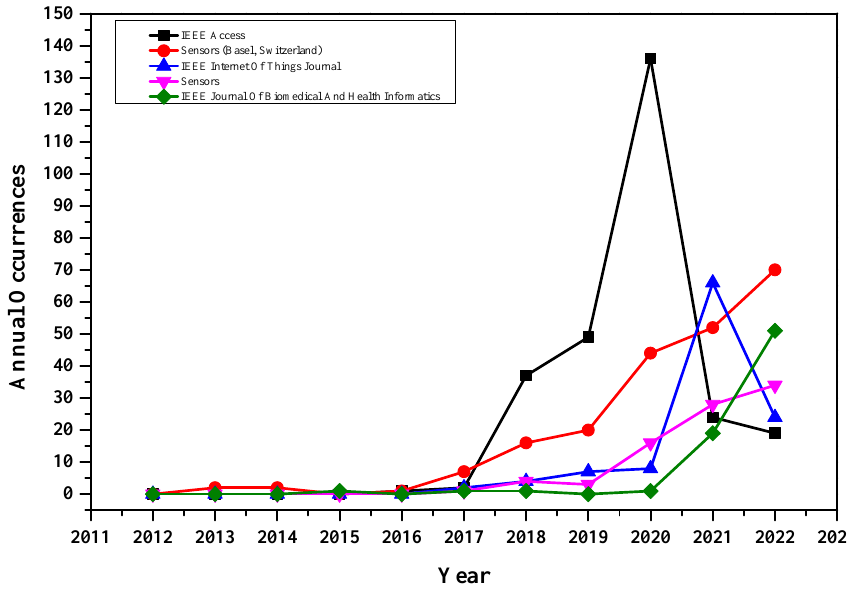
Figure 4. The number of publications per